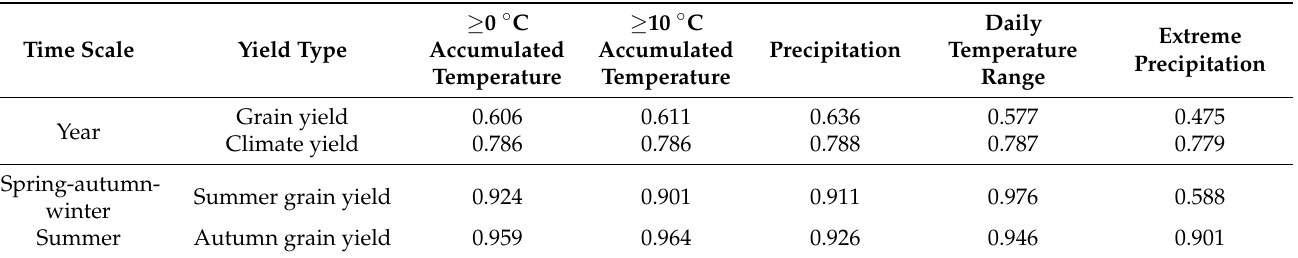
Table 4. The correlation degree between grain yield and indicators of water and thermal elements in Henan Province under different time